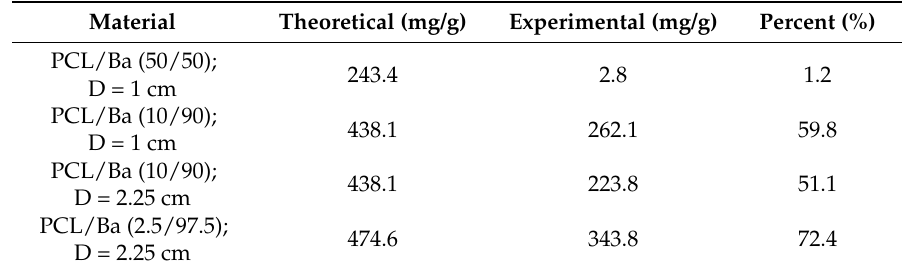
Figure 5. HR-TEM images of the PCL/Ba (10/90) sample after sulfate removal: ( a ) dissolved sulfate and ( b ) natural organic matter (NOM) as sulfate. Table 2. Theoretical and experimental sulfate adsorption capacity of PCL/Ba samples obtained from a small-scale column test (SST).